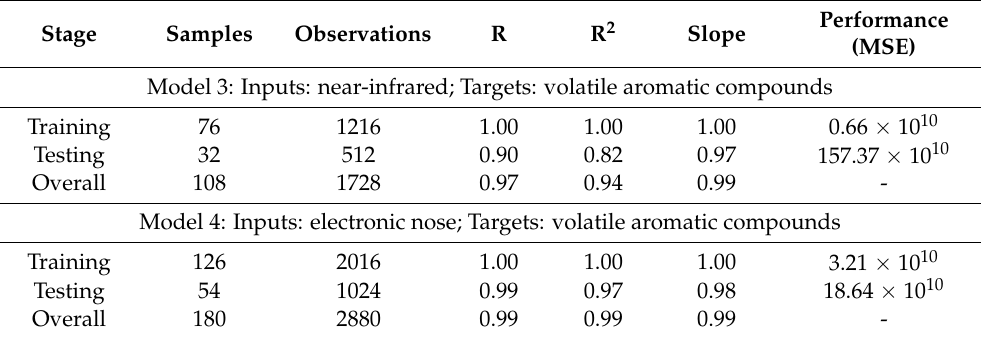
Table 5. The results of the artificial neural network regression Models 3 and 4. Abbreviations: R: correlation coefficient; R 2 : determination coefficient; MSE: means squared error.